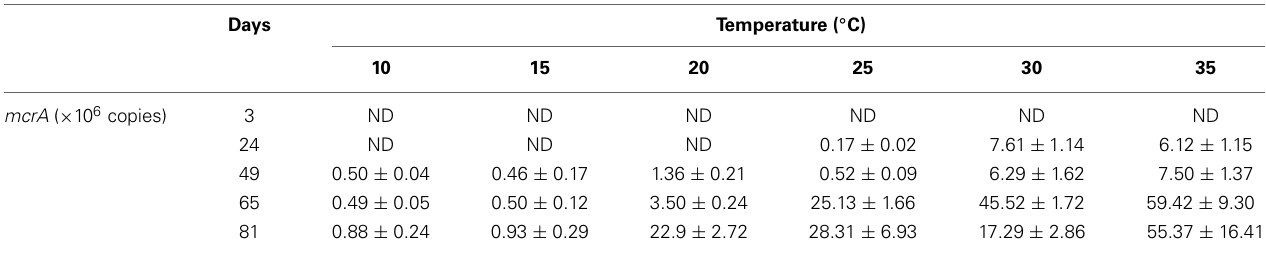
Table 1 | Temperature and time dependent total mcrA gene abundances a